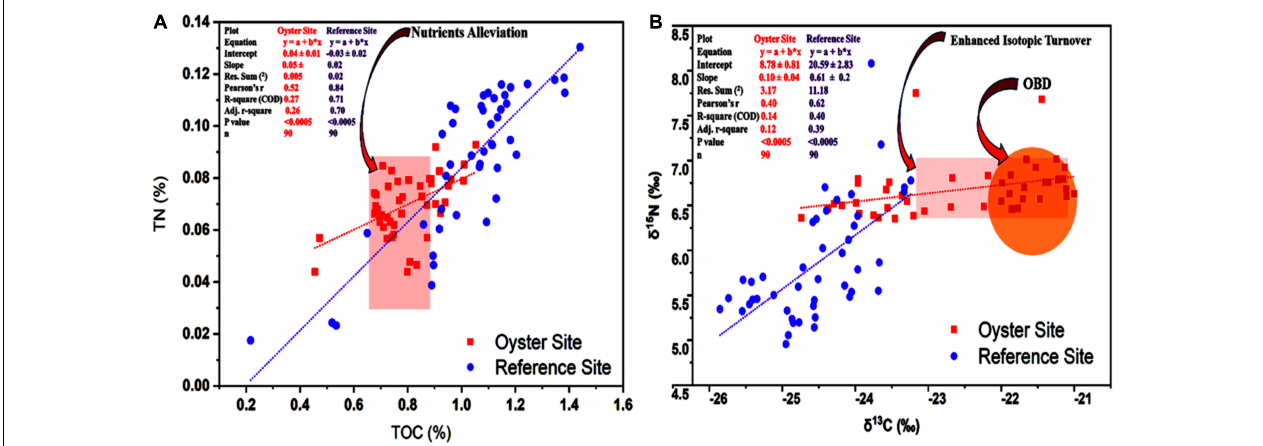
FIGURE 4 | Distribution and correlation of carbon and nitrogen and their stable isotopes. (A) Graph shows the correlation between total organic carbon (TOC)% and TN%. Red arrow pointing toward the light red vertical rectangle indicates the alleviated nutrient values at the site under OBD influence. (B) Correlation between is shown. The red arrow pointing toward the light red horizontal rectangle indicates the less depleted isotopic values and enhanced δ 13 C and δ 15 N turnover. The red arrow pointing toward the orange circle highlights the δ 13 C and δ 15 N values of OBD during nutrient alleviation. The red-colored square (cid:104) indicates the oyster site, and the purple-colored circle denotes the reference site. The text in the left upper corner denotes statistical comparison and contrast (cid:104) between the oyster and reference